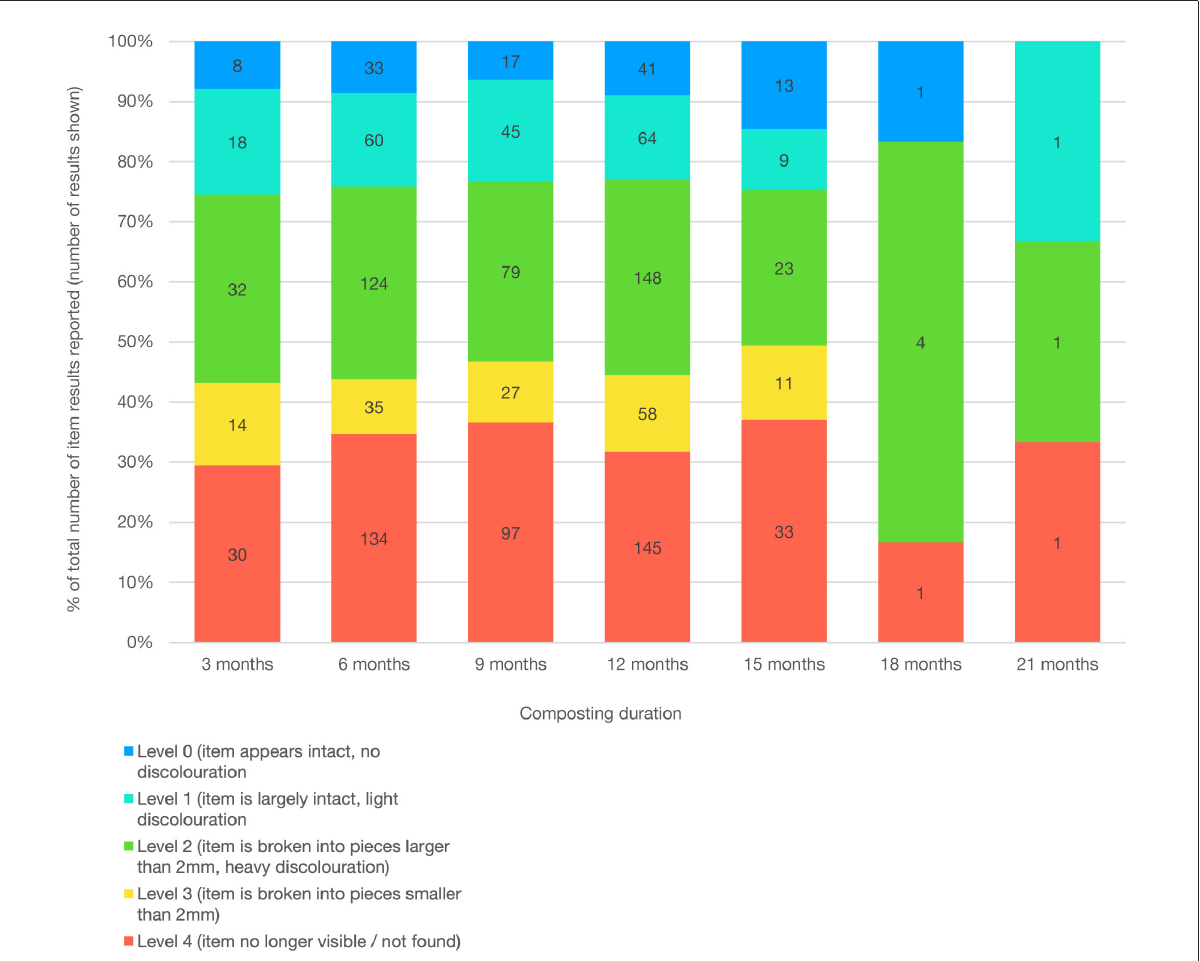
FIGURE12 Chart showing home compost experiment item degradation level according to composting duration. Values calculated from 1,307 item results